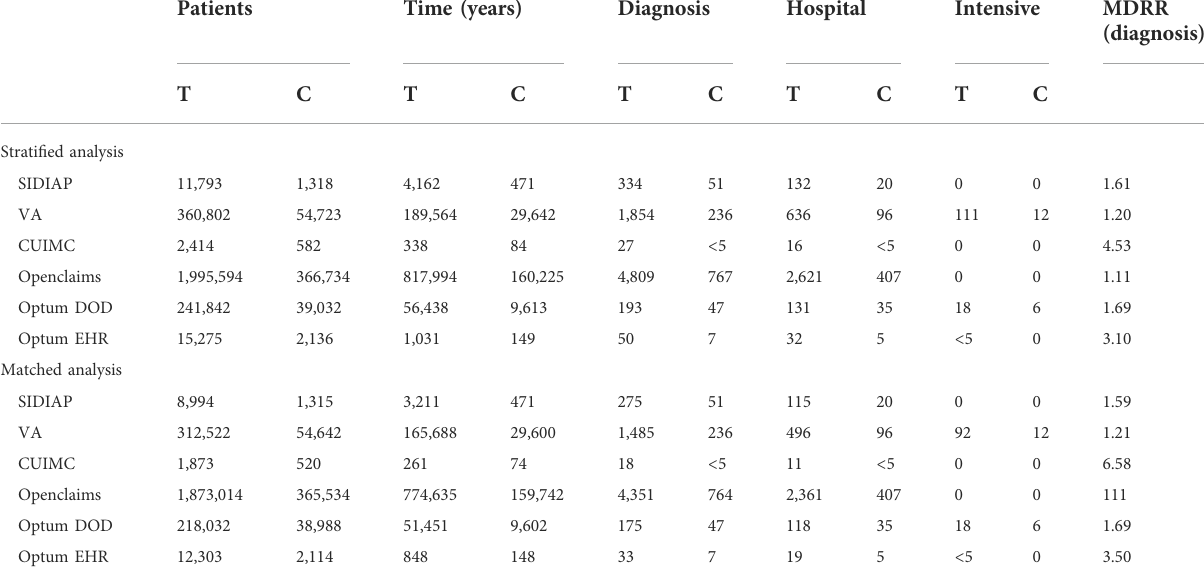
TABLE2PopulationsandCOVID-19outcomesforalpha-1blocker(T)and5ARI/PDE5(C)usercohorts.Wereportpopulationsize,totalexposuretime, outcome events (Covid diagnosis, hospitalization, and intensive services) and minimally detectable rate ratio (MDRR). MDRR is provided only for Covid diagnosis due to the space constraint. The database abbreviations are de fi ned under the heading Data Sources in the Method